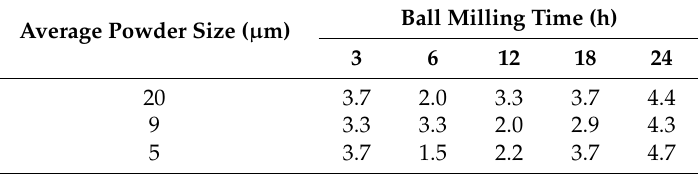
Table 2. Porosities of the Sintered Composites